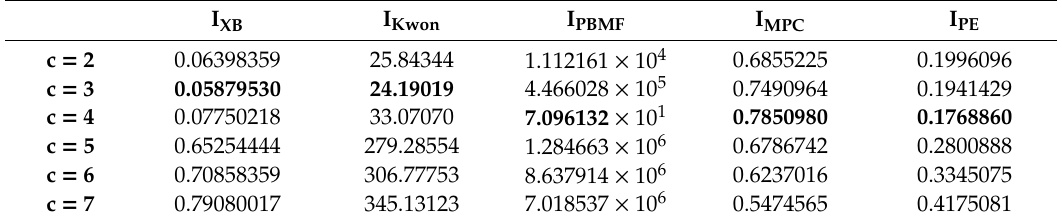
Table 4. Index values computed from membership matrix of 3P_4C